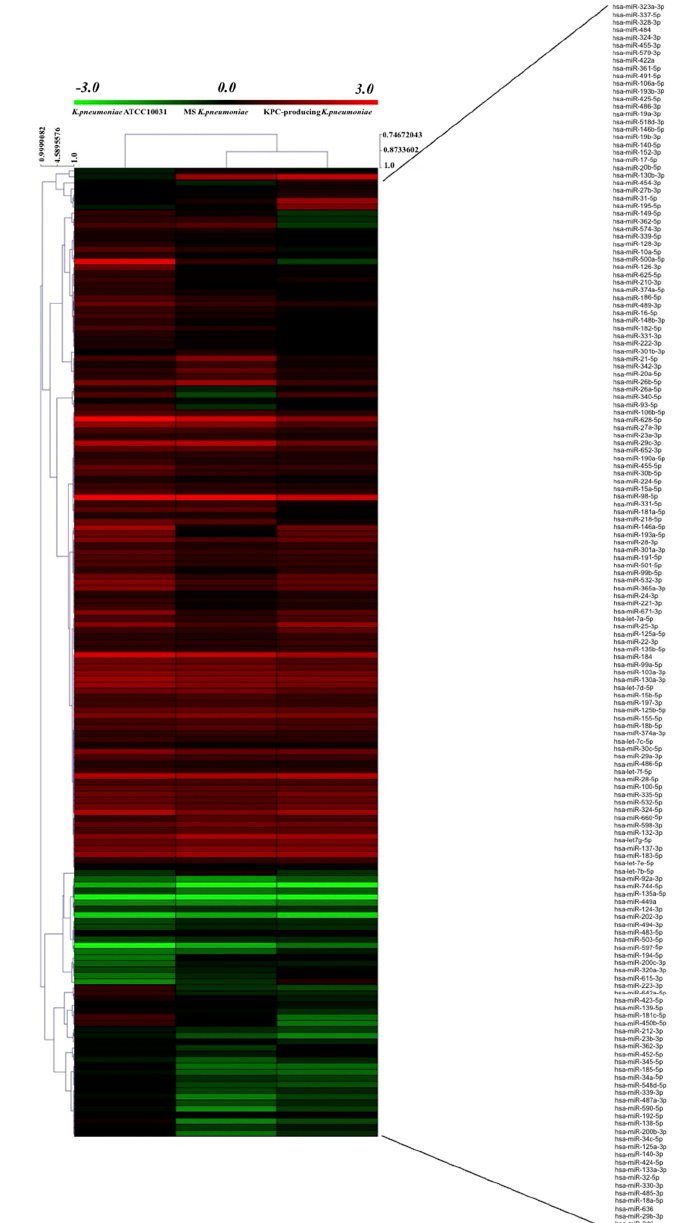
Figure 2. Heat map and hierarchical analysis of clusters. Heat map based on microarray results filtered and processed by bioinformatics analysis. Red indicates a greater expression than the control and green indicates a lower expression.